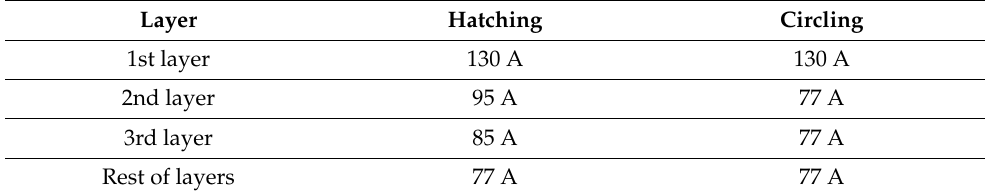
Table 3. Welding intensity for hatching and circling deposition